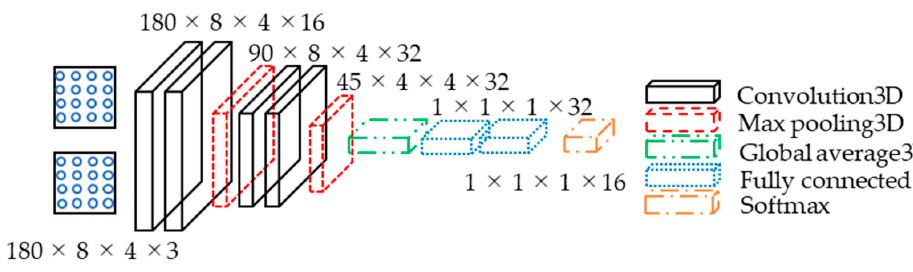
Figure 9. The model used for Xela sensor data. Table 7. Hyper parameters of 3-dimension CNN.